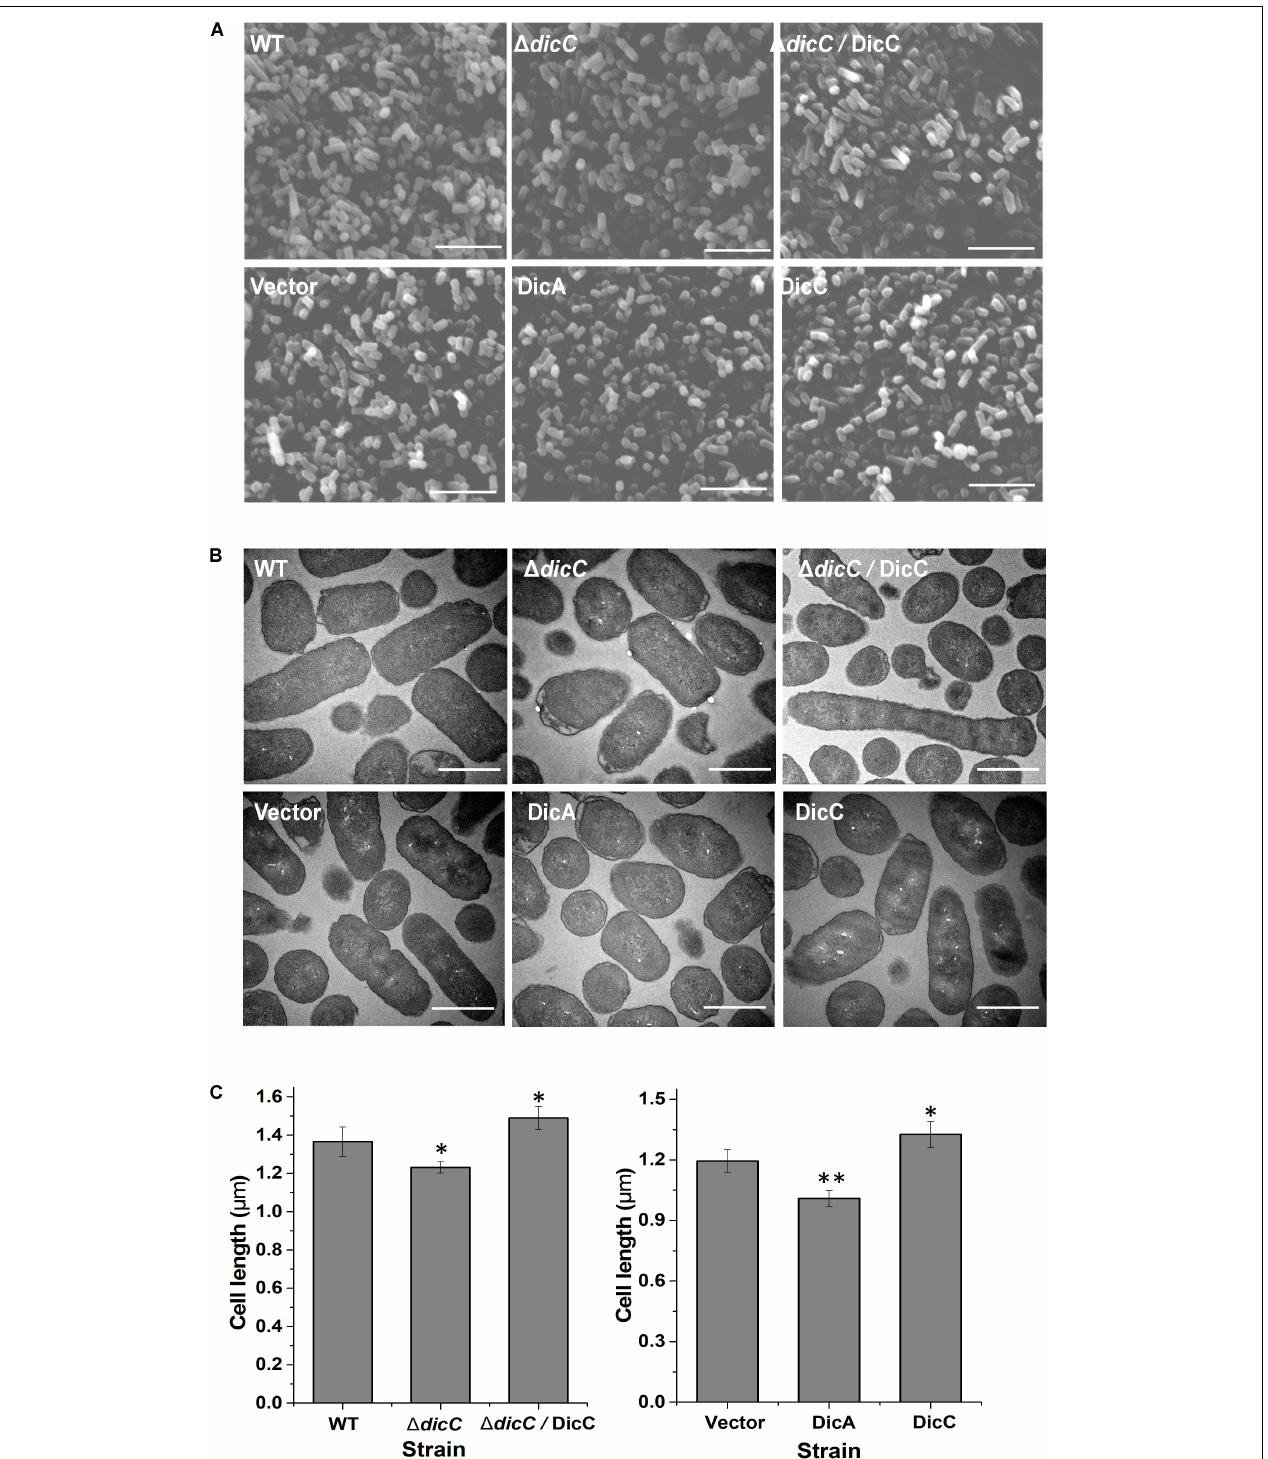
FIGURE 4 | Changes in the cell morphology of the (cid:49) dicC mutant train, (cid:49) dicC/ DicC complementary strain and dicA , dicC- overexpressing strain. (A) Scanning electron microscopy (SEM) (magnification of × 15,000). (B) Transmission electron microscopy (TEM) (magnification of × 15,000) photomicrographs. (C) Cell length statistical data of the WT, (cid:49) dicC mutant, (cid:49) dicC/ DicC complementary, vector, DicA, and DicC strains. Bar = 5 µ m (A) , bar = 1 µ m (B) . SEM images were used for the measurement of cell length. For each strain, cell length data were recorded from six fields of view, and at least 300 intact cells were measured. Significance was calculated by the t -test ( ∗ p < 0.05, ∗∗ p < 0.01, ∗∗∗ p < 0.001).